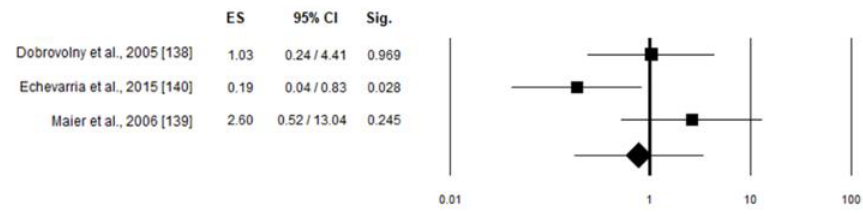
Figure 4. Forest plots for skewed versus random XCI in mild and moderate-severe symptomatic Fabry carriers. Heterogeneity I 2 = 65.43%, p = 0.055 .